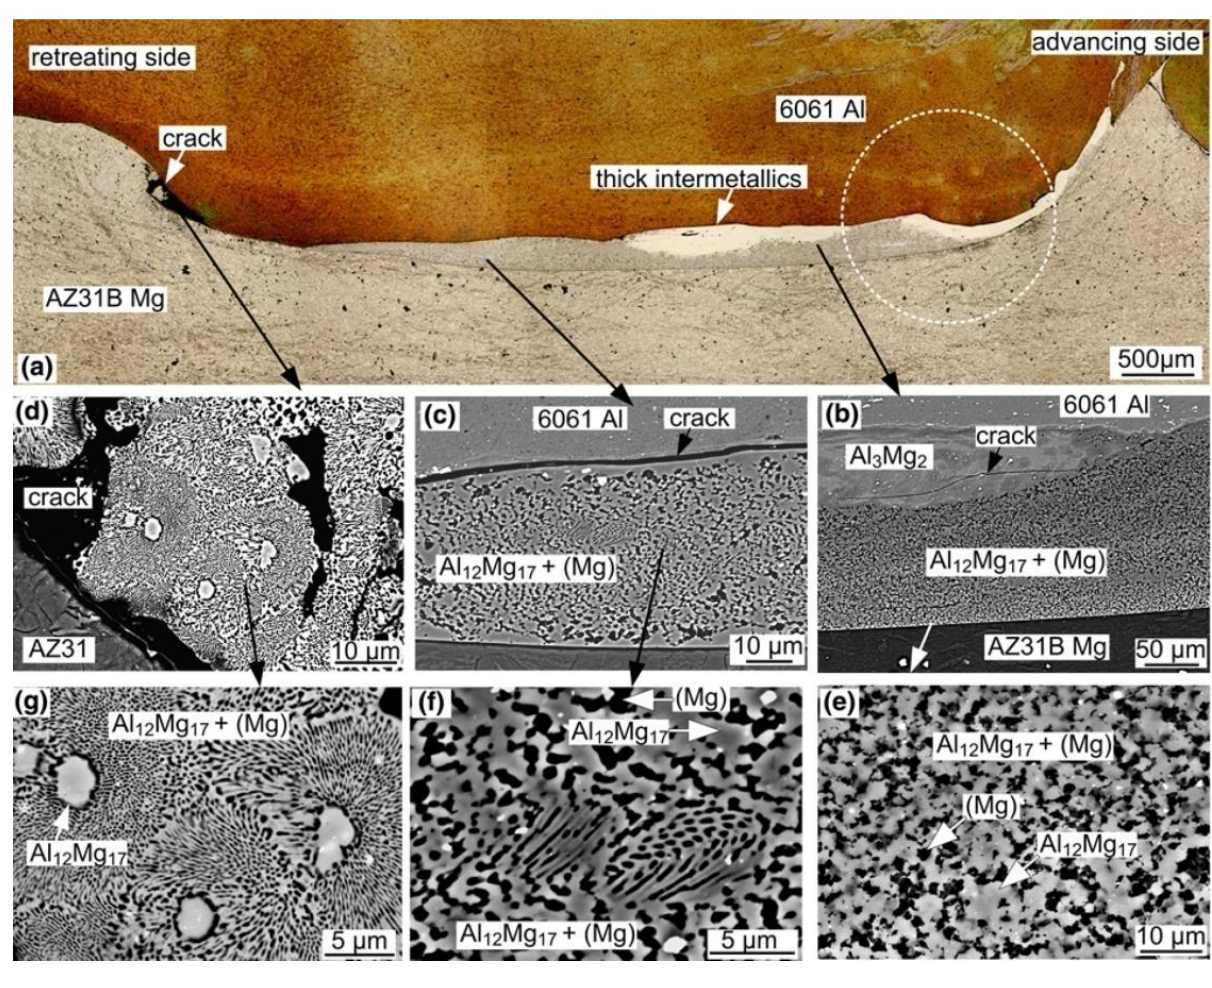
Figure 3. Microstructures of intermetallic compounds (IMCs) in friction stir welded Mg-Al joint [28]. ( a ) Optical micrograph; ( b – g ) images of intermetallic